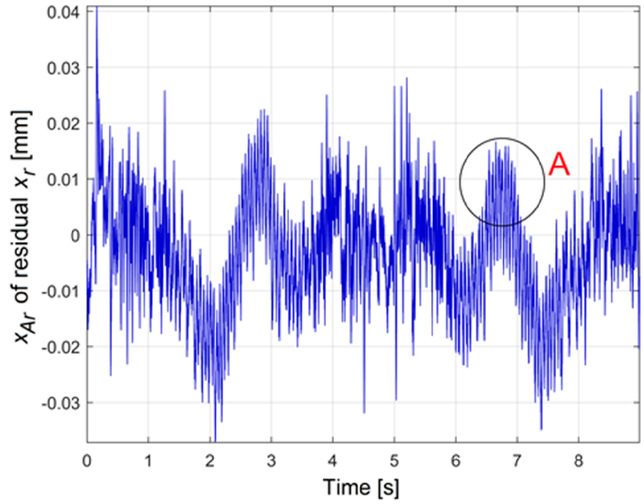
Figure 8. The average evolution x Ar of the residual x r for x